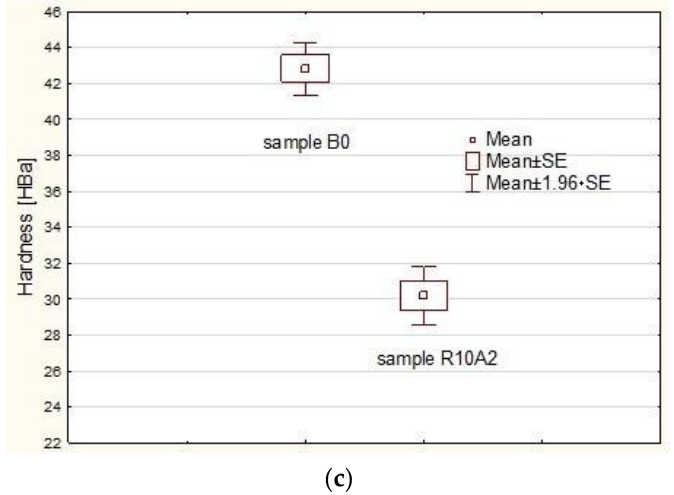
Figure 4. Frame-whisker chart for: ( a ) sample B0 versus sample A2; ( b ) sample B0 versus sample R10; ( c ) sample B0 versus sample R10A2, where: mean ± SE was mean ± standard error and mean ± 1.96 × SE was confidence interval for the mean.